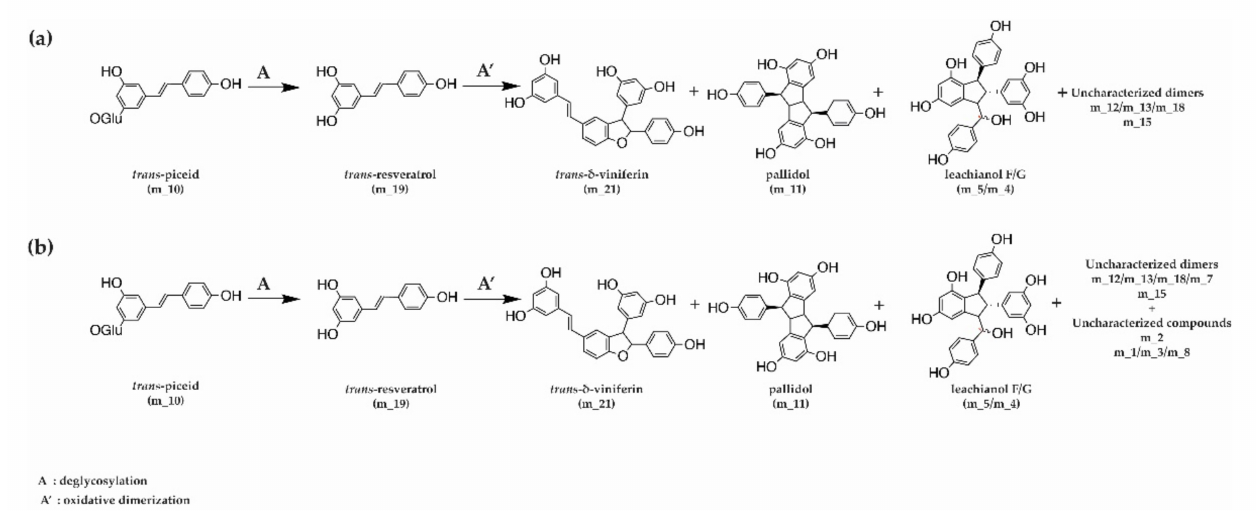
Figure 9. Schematic metabolization of trans -piceid by fungal extracellular proteins from ( a ) D. seriata and ( b ) N. parvum . Concerning trans -piceatannol, we observed that both extracellular proteins of D. seriata and N. parvum were able to metabolize this compound. The complete metabolization of trans -piceatannol by D. seriata was achieved in 10.5 h, while the full metabolization by N. parvum occurred in only 4.95 h (Figure